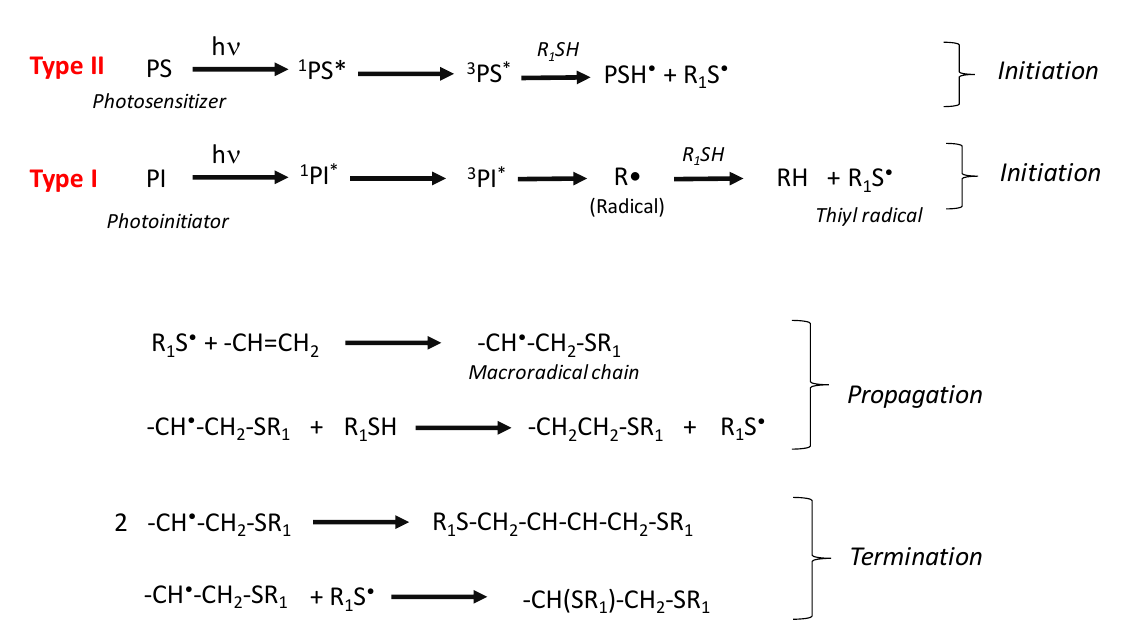
Figure 4. Overall mechanism related to the thiol-ene process.